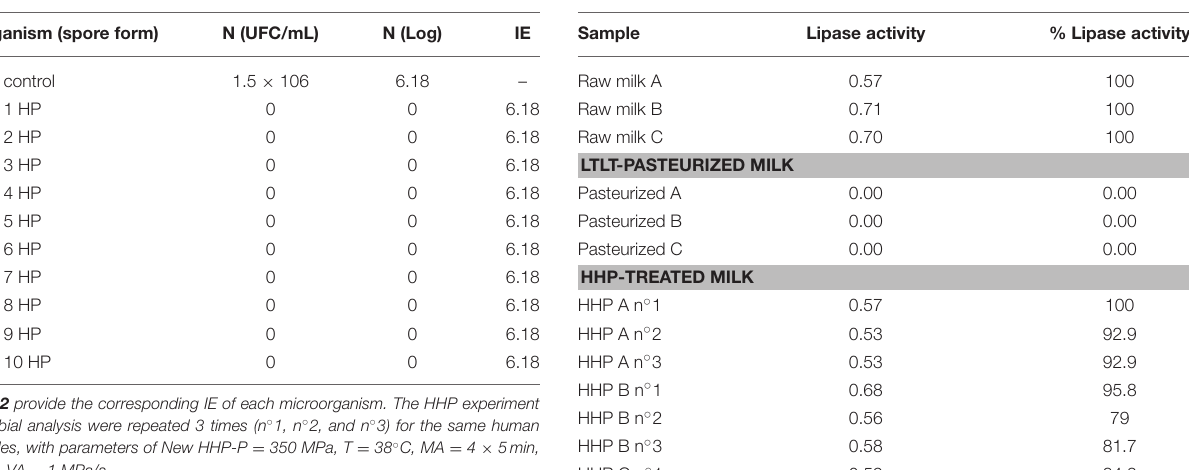
TABLE 3 | Lipase activity of raw human milk samples and milk samples after thermal “Low-Temperature, Long-Time” (LTLT) pasteurization and High Hydrostatic Pressure (HHP)